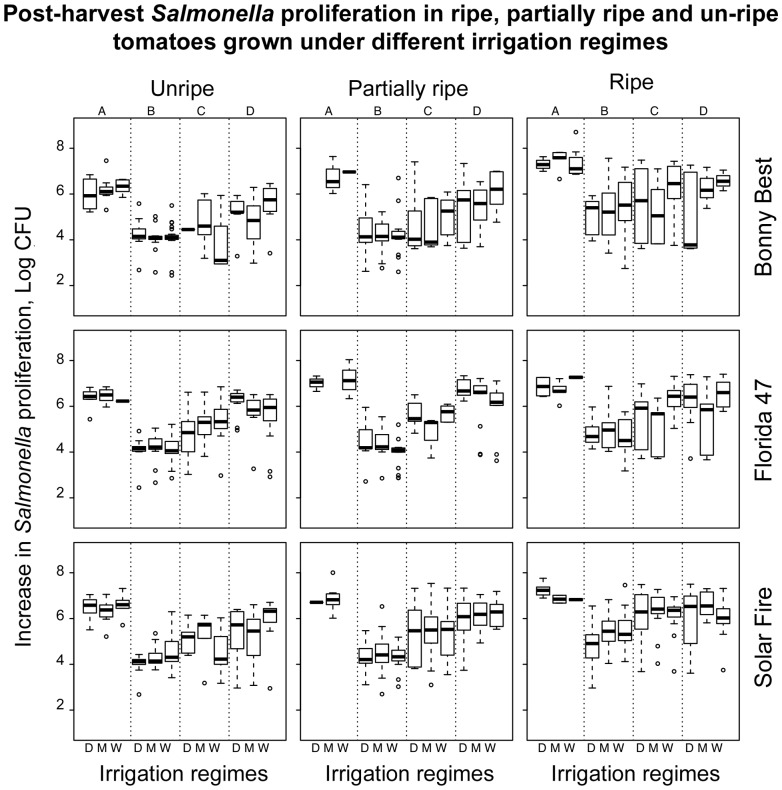
Post-harvest proliferation of Salmonella in ripe and un-ripe tomatoes grown under different irrigation regimes.Tomatoes (cultivars Bonny Best, Florida-47, and Solar Fire, indicated on the right y-axis) were grown under differential irrigation regimes: D (“dry”) = 6%, M (“medium”) = 10% (recommended for tomato production), W (“wet”) = 12% volumetric soil moisture contents were imposed within two weeks of the first harvest. Four independent samplings (A, B, C, D, top x-axis) were conducted: once in Spring 2011 and Spring 2012, and twice in Fall 2012. At each sampling, at least 55 tomatoes from each treatment were harvested and infected with ∼102 CFU of S. Typhimurium 14028 or the cocktail of the six strains of Salmonella recovered from tomato-related human outbreaks. Upon completion of a 1-week incubation, Salmonella cells were recovered on Xylose Lysine Deoxycholate (XLD) agar and an increase in proliferation was calculated as Log (CFU/fruitHARVEST/CFU/fruitINOCULUM) and plotted on the y-axis for each tomato cultivar. Data for infections with both types of inocula are shown. “Unripe” tomatoes were mature green (stage 1 of the USDA Color Classification Requirements, http://ucanr.edu/repository/a/a=83755) at field harvest and Salmonella infection and were either breakers, turning, pink or light red (stages 2, 3, 4 or 5) upon completion of the 1 week-long incubation. “Partially ripe” refers for tomatoes that were mature green, breakers, turning or pink (stages 1, 2, 3 or 4) at field harvest and infection with Salmonella, but turned light red or red (stages 5 or 6) upon completion of the incubation. “Ripe” refers to tomatoes that were light red or red (stages 5 or 6) at field harvest and turned or stayed red during the incubation under the laboratory conditions. In box plots boxes include the lower and upper quartiles, thick lines within the box are the medians and whiskers indicate the degree of dispersion of the data. Outlier data are shown as dots.